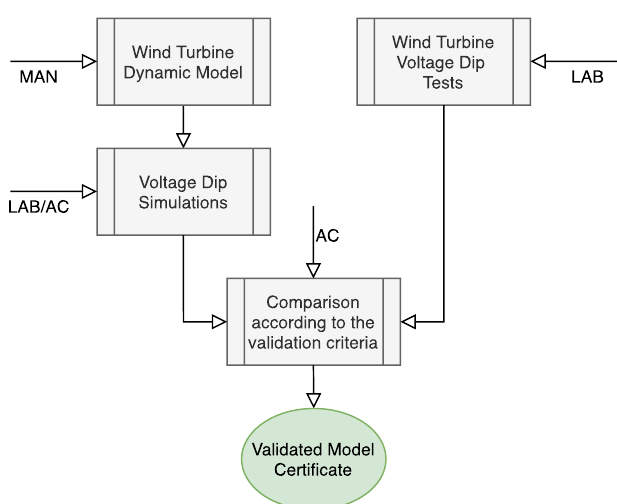
Figure 1. WT model validation flowchart under voltage dips, following NTS